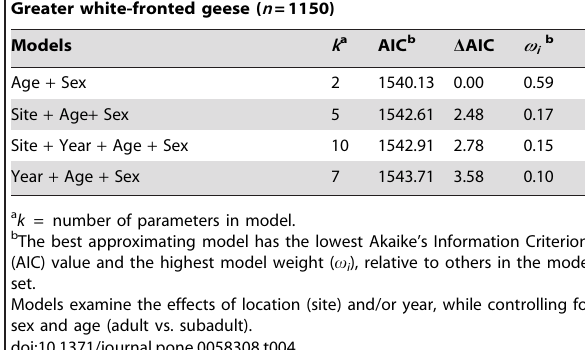
Table 4. Logistic regression models of variation in avian influenza virus (AIV) seroprevalence for greater white-fronted geese sampled in Alaska, USA, 2008–2010.